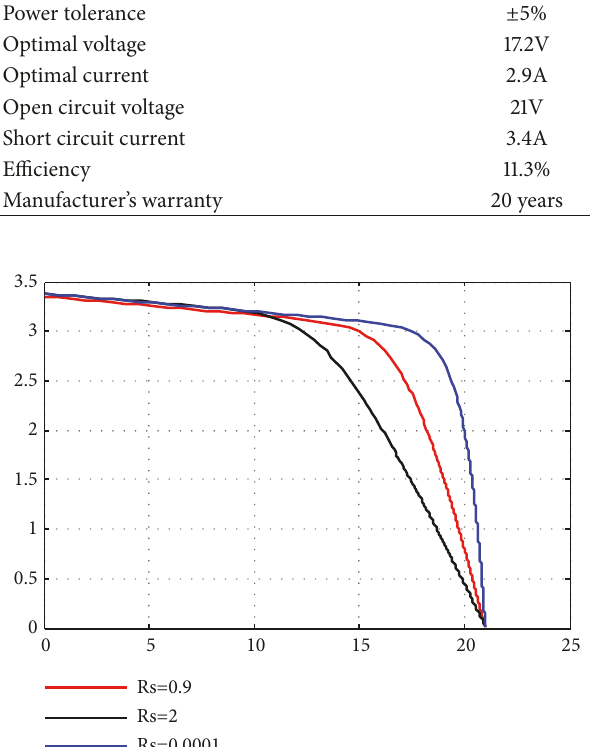
Figure 4: Influence of series resistance on the 𝐼 𝑝 V = 𝑓(𝑉 𝑝 V )